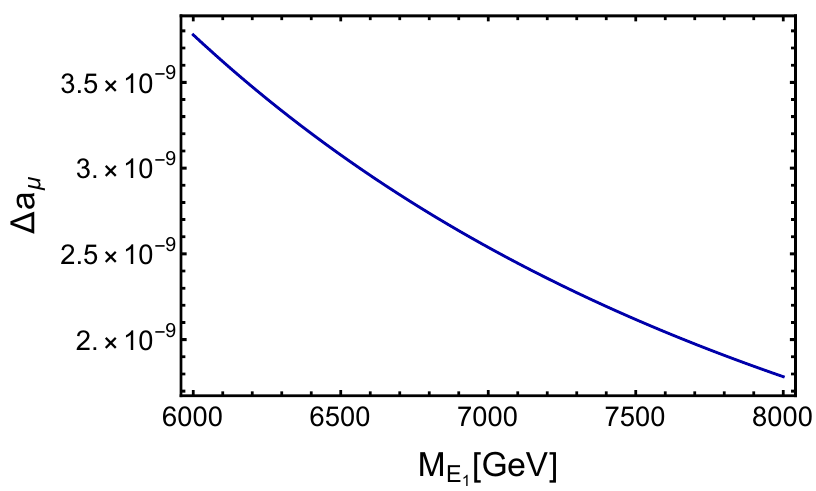
Figure 8 . Muon anomalous magnetic moment as a function of the charged exotic lepton mass M E